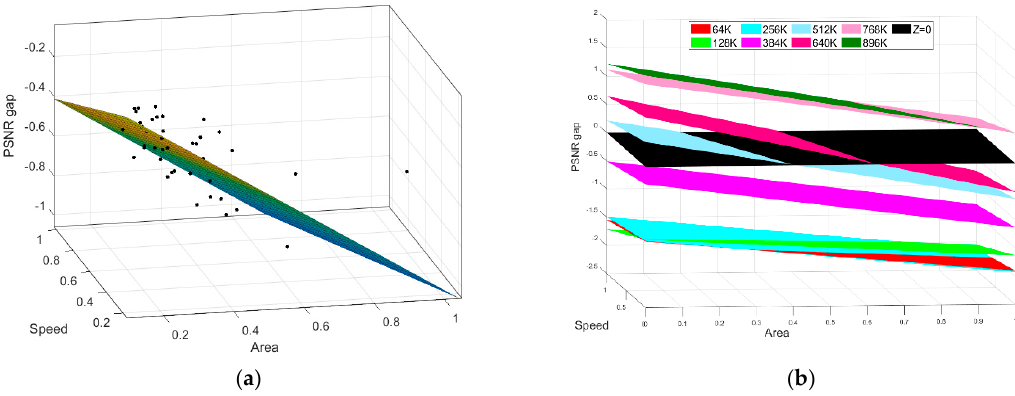
Figure 2. The moving object’s area, speed, and PSNR results. ( a ) Plane generated from 43 moving objects using robust linear regression at 64 Kbps coding bitrate and ( b ) Planes created from each individual coding bitrate and the z = 0 plane (black) show the same PNSR as the 64 Kbps video transferred by the wired network. In order not to make the graph look too cluttered, the layer interval is set to 128 Kbps.